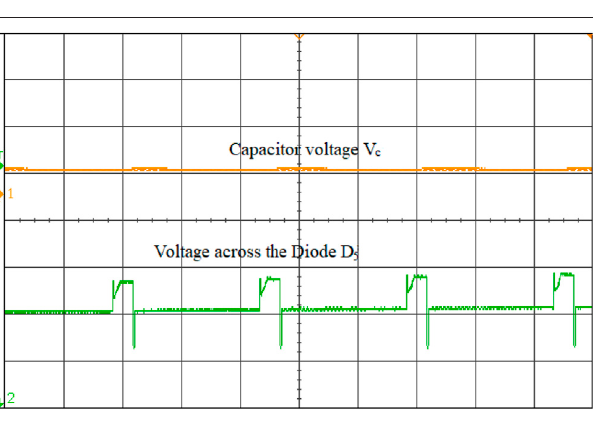
FIGURE 16 | Capacitor Voltage Vc and Diode Voltage D 5